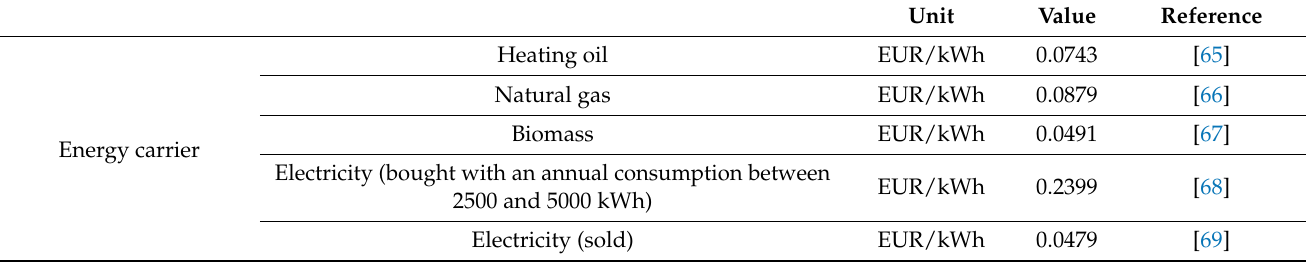
Table 6. Cost of the energy carriers for the starting year, cost of the different energy renovation measures and estimated investment cost of the reference